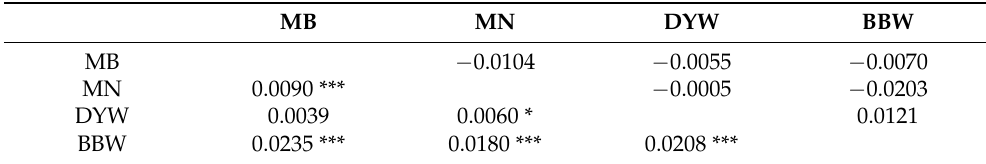
Table 2. Matrix of pairwise F ST among four populations based on microsatellite DNA (below diagonal) and mitochondrial gene (above diagonal) in E. awoara